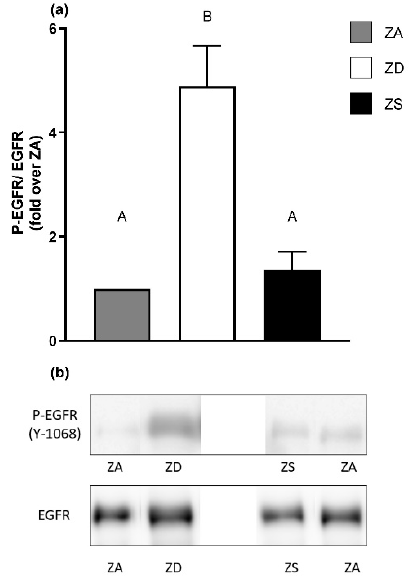
Figure 3. EGFR phosphorylation is increased in zinc deficiency. EGFR receptor phosphorylation at Y1068 in zinc-adequate (ZA), -deficient (ZD) and -supplemented (ZS) A549 cells was determined by Western blotting and normalized over the pan EGFR. Phosphorylation at Y1068 is five-fold increased in ZD cells compared to ZA cells. ZS cells exhibit comparable phosphorylation as ZA cells. Data for n = 9 independent experiments as means + SEM are depicted ( a ). One representative Western blot is shown ( b ). Statistical significances were calculated with one-way ANOVA and Tukey’s post hoc test ( p < 0.05). Statistically different data sets do not share the same letter.